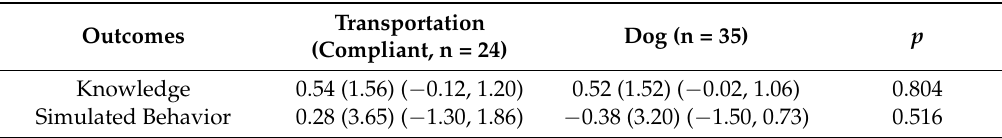
Table 4. Change in outcome scores (Post-Pre), standard deviation, and 95% confidence intervals for participants, and results of ANCOVA Analysis.